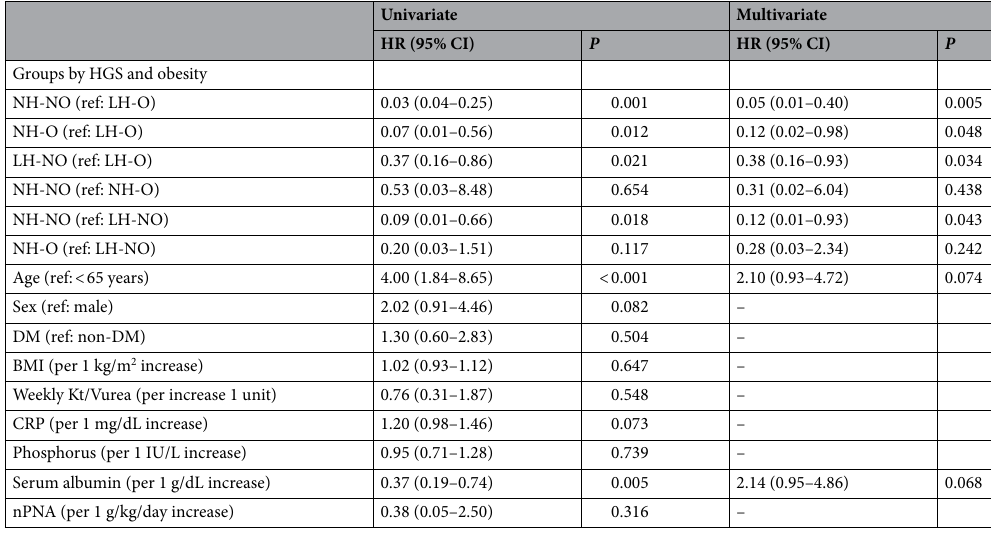
Table 2. Cox regression analyses for patient death according to groups. Multivariate analysis was adjusted for age and serum albumin with P < 0.05 in univariate analysis. HR hazard ratio; CI confidence interval; HGS handgrip strength; NH-NO patients with normal handgrip strength and without obesity; NH-O patients with normal handgrip strength and with obesity; LH-NO patients with low handgrip strength and without obesity; LH-O patients with low handgrip strength and with obesity; DM diabetes mellitus; BMI body mass index; CRP C-reactive protein; nPNA normalized protein equivalent of total nitrogen appearance.